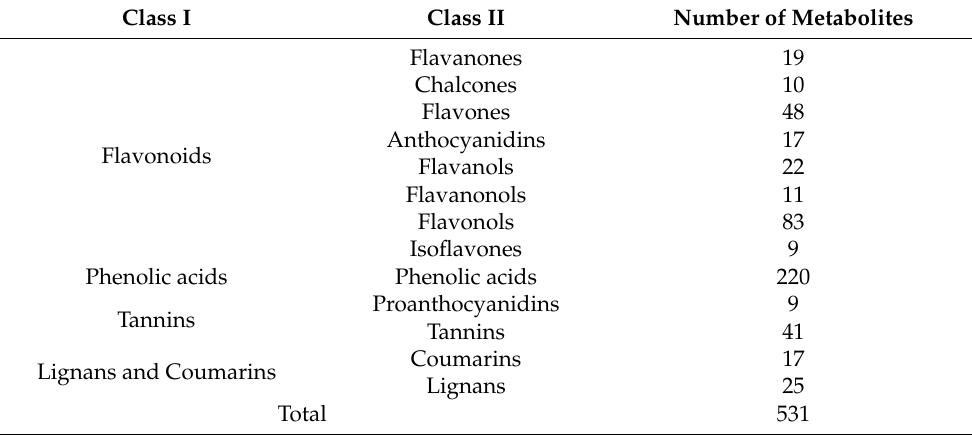
Table 2. Classification of polyphenol metabolites in Rosa xanthina f. spontanea